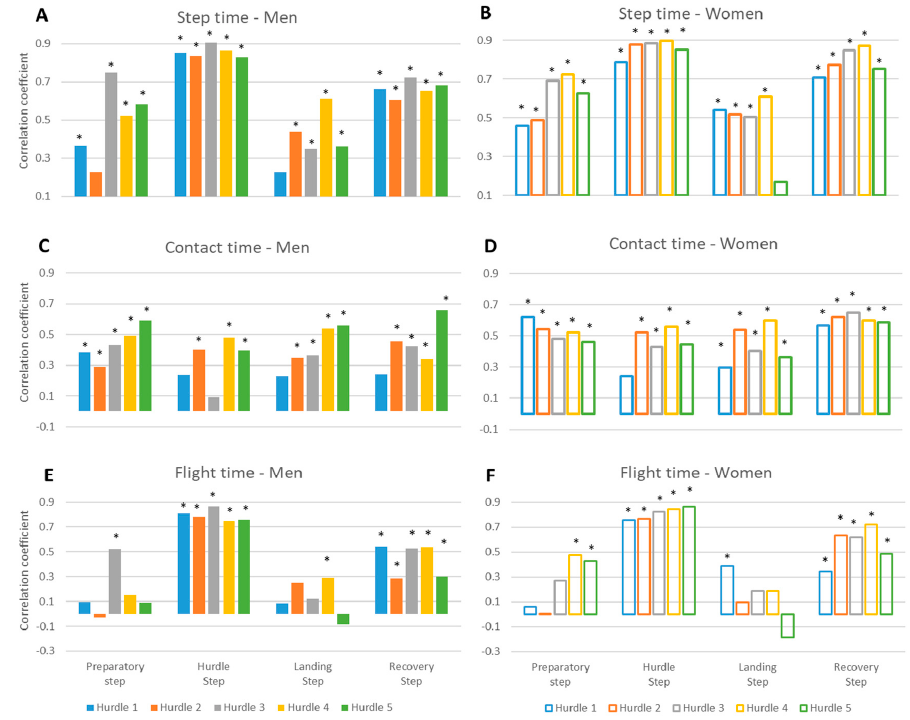
Figure 4. Pearson’s correlation coefficient (r) between temporal parameters (( A , B ) step time; ( C , D ) contact time; and ( E , F ) flight time) and the hurdle-unit splits times during the 44th Spanish Indoor and 12th IAAF World Indoor Championships. Correlations: * p < 0.05.